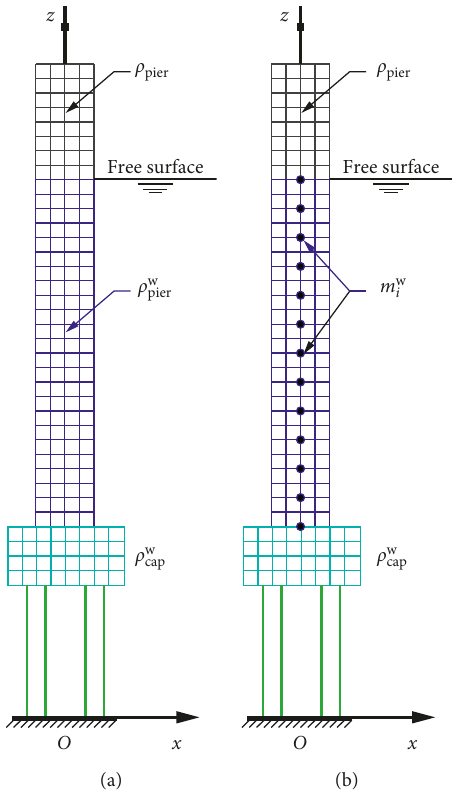
Figure 17: Two equivalent models considered: (a) Equivalent model I; (b) Equivalent model